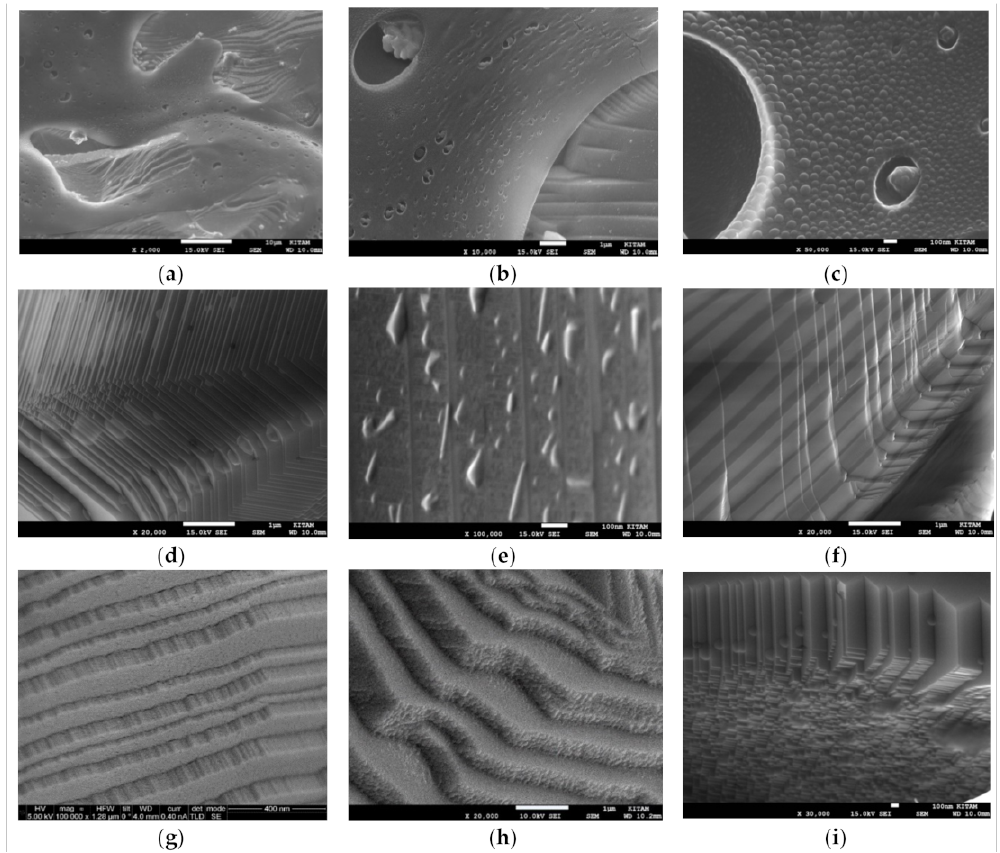
Figure 15. SEM images of the BaTiO 3 particles after microwave irradiation and plasma generation at 1800 W for 10 min in a region without electrical treeing. ( a ) Formation of porous skin on the particle surface (scale bar = 10 µ m); ( b ) Pore distribution and the structure of skin (scale bar = 1 µ m); ( c ) Phase separation on the surface skin (scale bar = 100 nm); ( d ) Delamination and formation of fine layer structures (scale bar = 1 µ m); ( e ) Phase separation and nano-size void formation within the layered structures, (scale bar = 100 nm); ( f ) Delamination (scale bar = 1 µ m); ( g ) Image of delamination at high magnification, (scale bar = 400 nm); ( h ) Fragmentation of the layered structures, (scale bar = 1 µ m); ( i ) Fragmentation of the layered structures in progress, (scale bar = 100